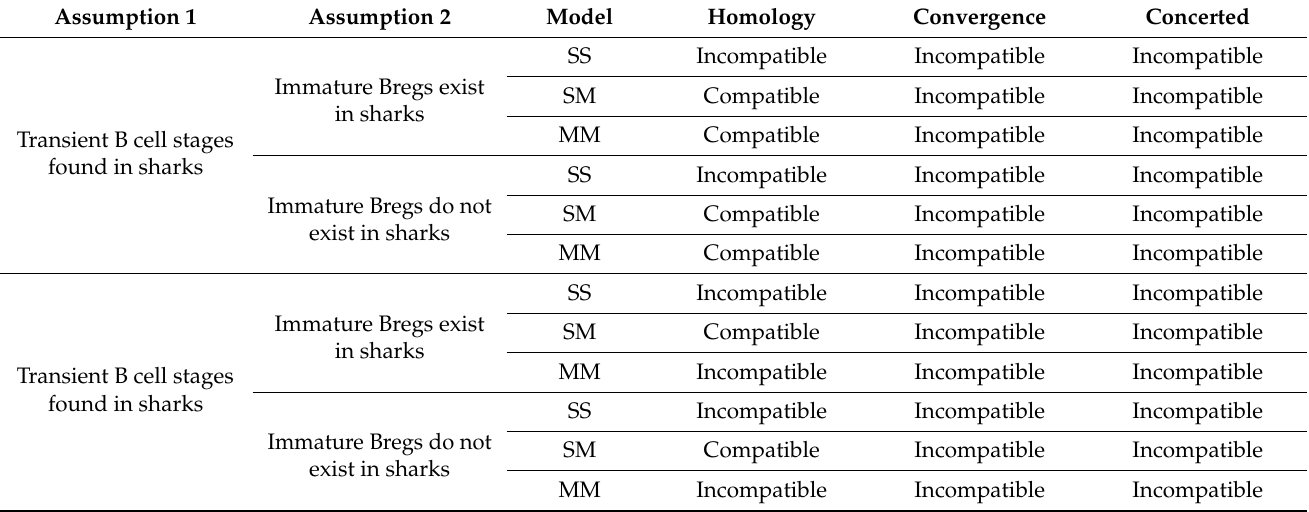
Figure 6. Three models have been suggested for Breg differentiation, adapted from [13]. In single–single model; each Breg type arises from a single Bregs progenitor. In single–multi model; one pre-Bregs gives rise to multiple Bregs. In the multi-multi, environmental conditions induce differentiation of Bregs from the nearest B cell homolog. Table 3. Feasibility of Breg models based on known evolutionary